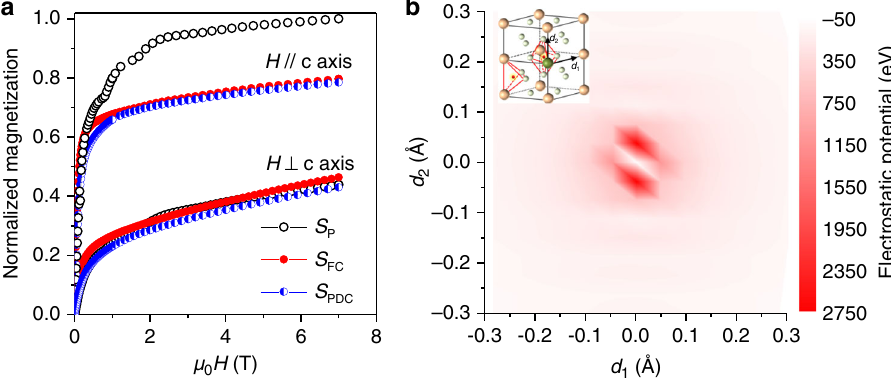
Fig. 4 Dependence of the magnetocrystalline anisotropy of SmCo 5 on the charging states. a Easy and hard axis magnetization curves of S P , S FC , and S PDC samples. For comparison, the magnetization was normalized by the magnetization value of the S P sample at 7 T along the easy axis. b Contour plot of the difference of the electrostatic potential around Sm 3 + between SmCo 5 and SmCo 5 H 3 within (100) plane. Inset denotes the directions of d 1 (along [010]) and d 2 (along [001]) in hexagonal structure.